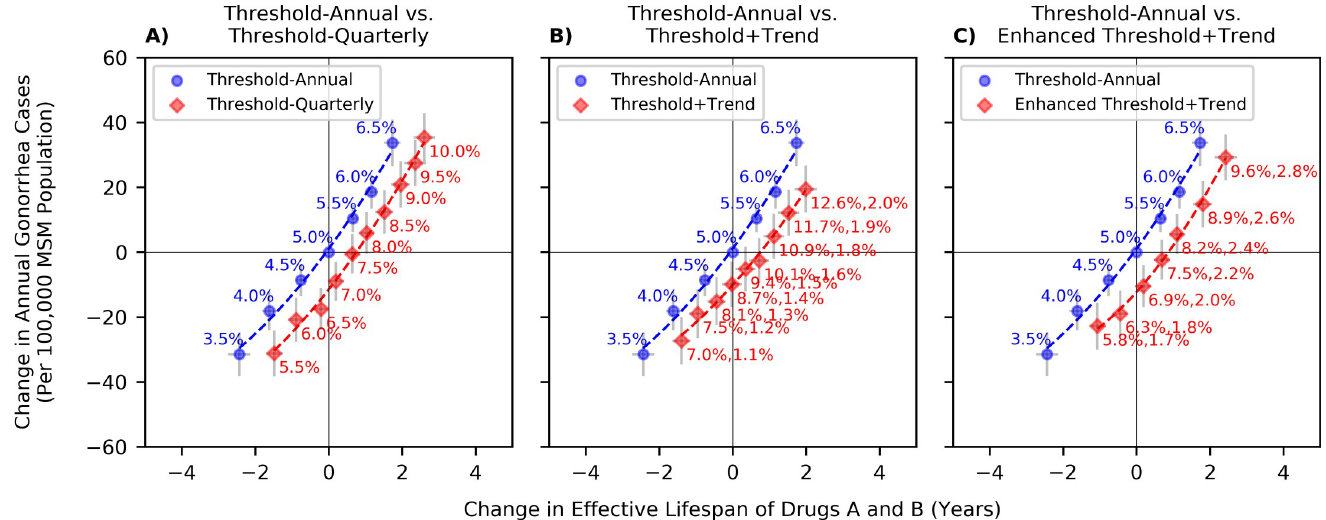
Fig 3. Comparing the performance of policies in Table 1 with respect to the current policy. The origins in these figures reflect the current policy that recommends switching the antibiotic used for empiric treatment once the estimated resistance prevalence exceeds 5% [8,10].The numbers on the curves of “Threshold—annual” and “Threshold—quarterly” strategies represent the threshold of resistance prevalence to switch the first-line therapy of gonorrhea, and the 2 numbers on the curves of “Threshold + trend” and “Enhanced threshold + Trend” strategies represent the 2 thresholds used to inform switching: resistance prevalence (first %) and percentage point change in the resistance prevalence (second %). S6 Fig in S1 Text shows that the comparative performance of these strategies is maintained when the simulation length is reduced from 50 years to 25 years. MSM, men who have sex with men.